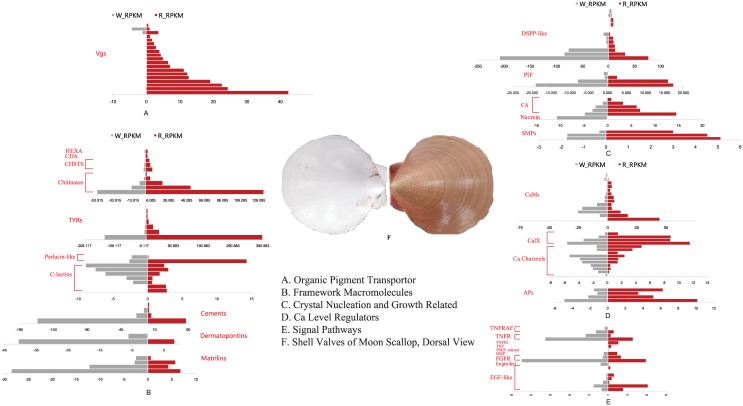
Crystal formation-related genes differently expressed in the RS and WS.The macromorphology of white shell (left) and red shell (right) was shown in F. And the different expressed genes between RS and WS involved in organic pigment transportor (A), framework macromolecules (B), crystal nucleation (C), Ca2+ level regulators (D) and relative signal pathways (E) were represented respectively.